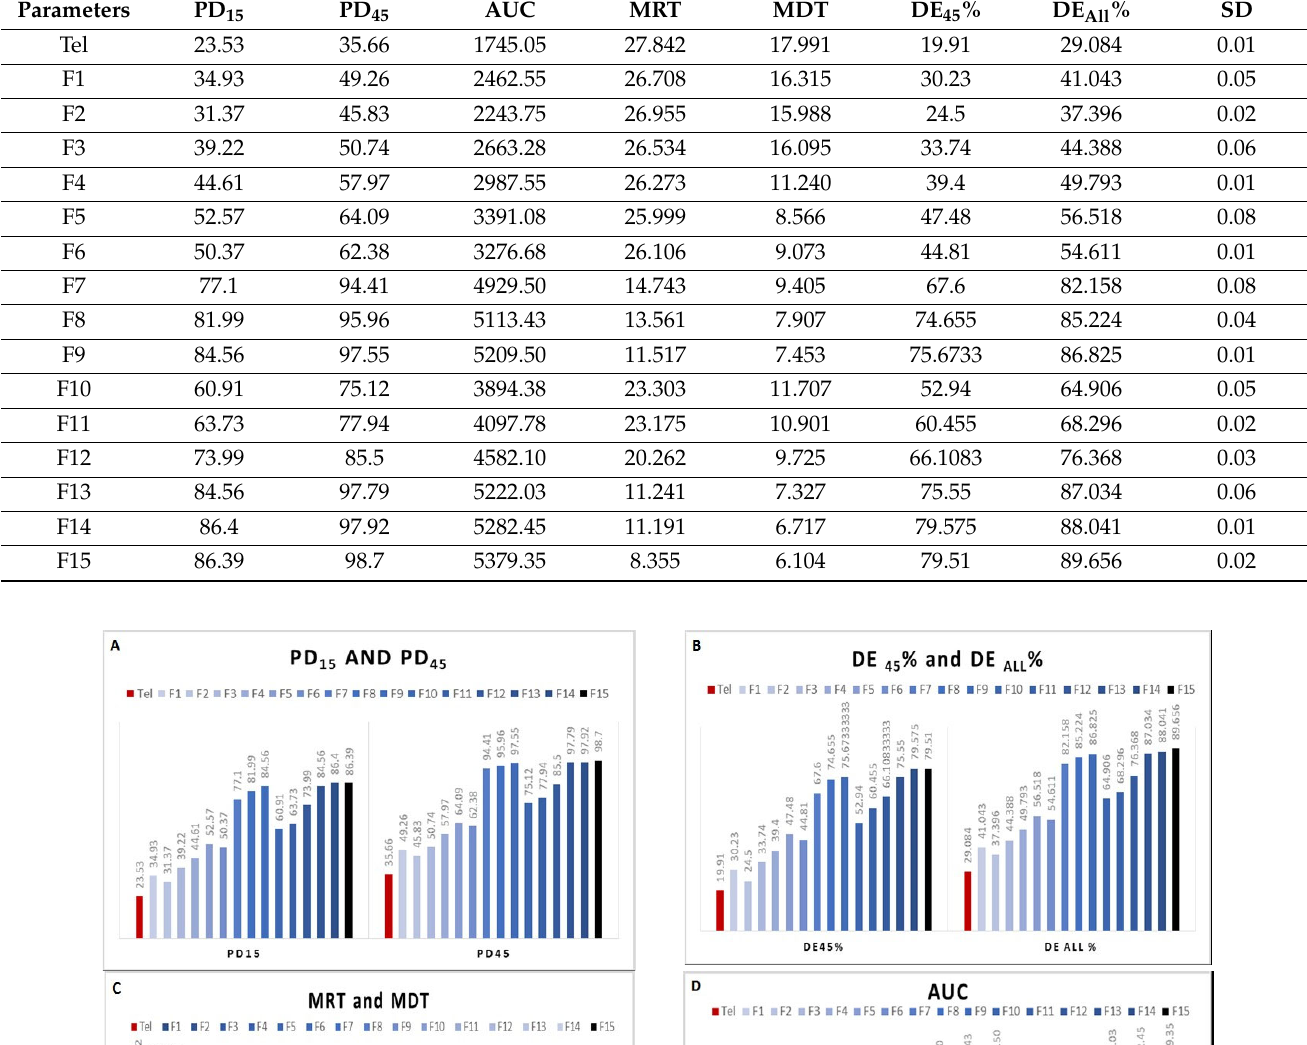
Table 6. Parameters for assessing the similarity and difference between dissolution data of plain Tel